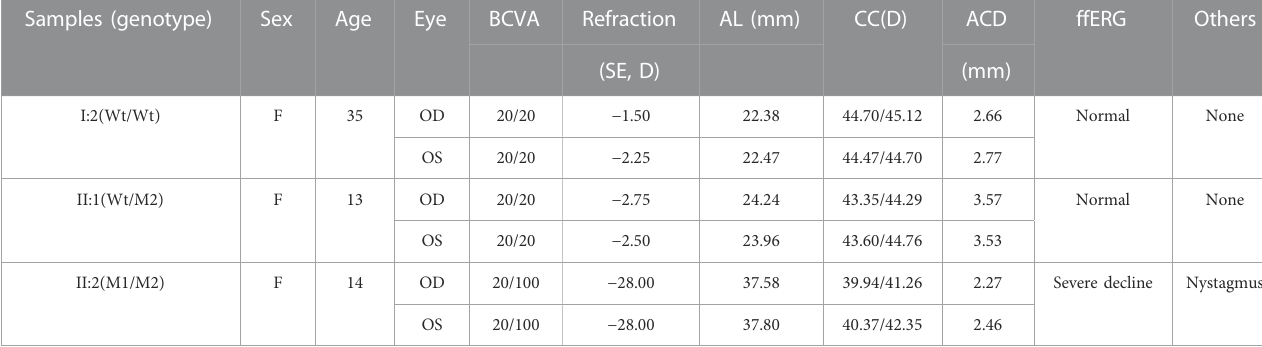
TABLE 2 Ophthalmological examination of DBS patient with early-onset high myopia and unaffected members. Samples